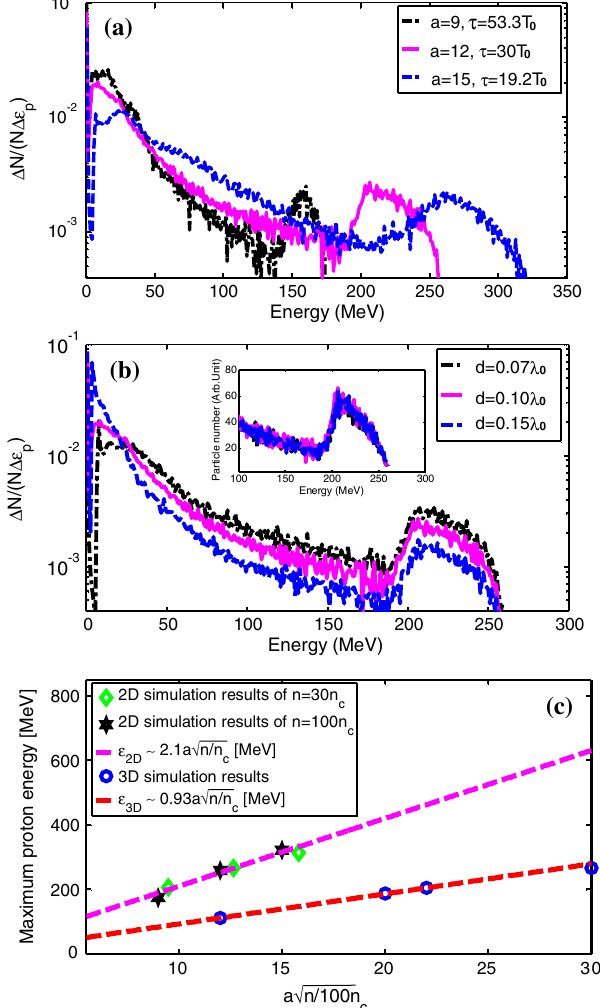
FIG. 4. 2D PIC simulation results of variation of the energy spectrum with respect to the laser amplitude a and the laser pulse duration (cid:4) (a), and the thickness d of the center proton layer (b). The laser energy is fixed to be 9.6 J and other laser parameters are the same as in Fig. 2. Plot (c) shows the maximum proton energy scaling as given by Eqs. (1) and (2) obtained in 2D and 3D PIC